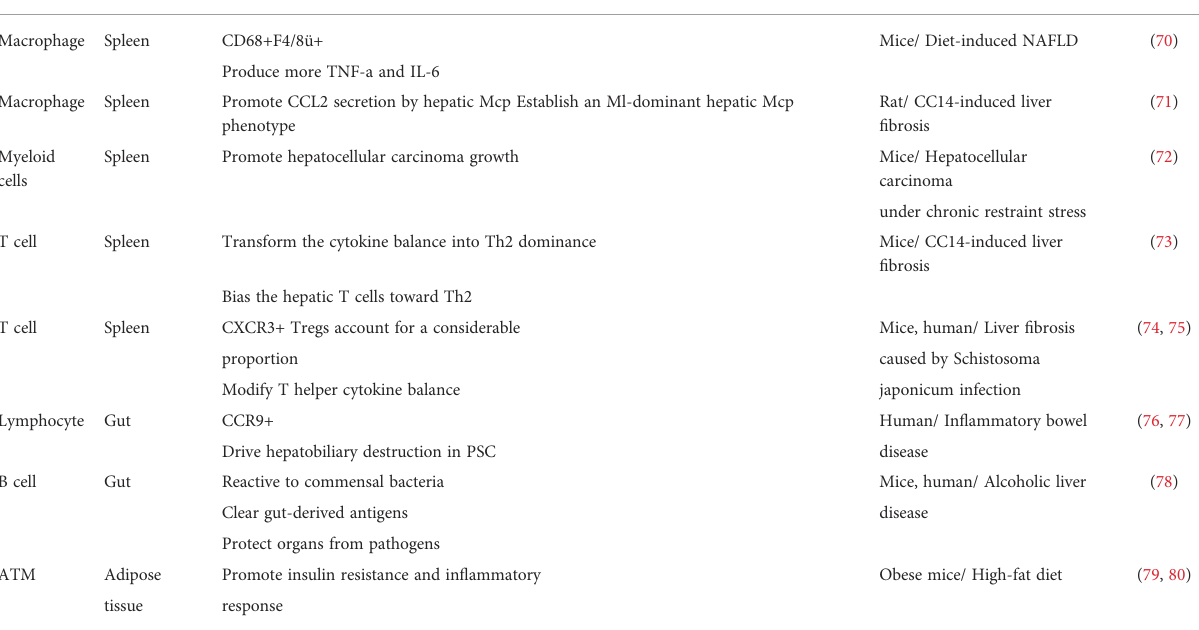
TABLE 1 Immune cells migrating from extrahepatic organs to the